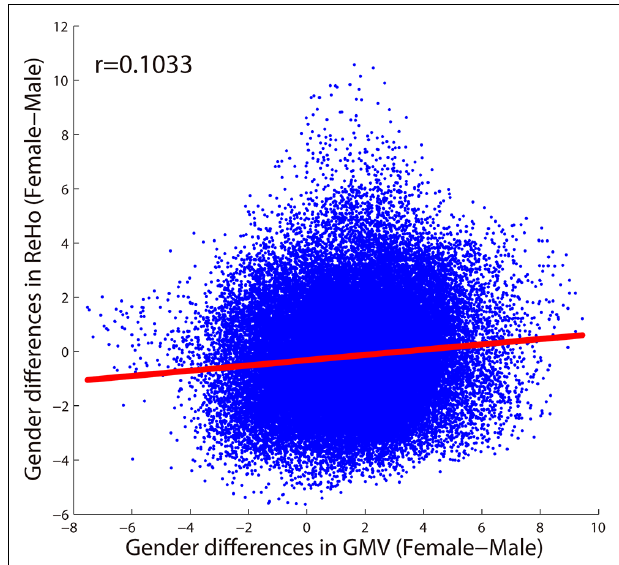
FIGURE 5 | The spatial correlation between gender differences in GMV and gender differences in ReHo across voxels within the GM mask.